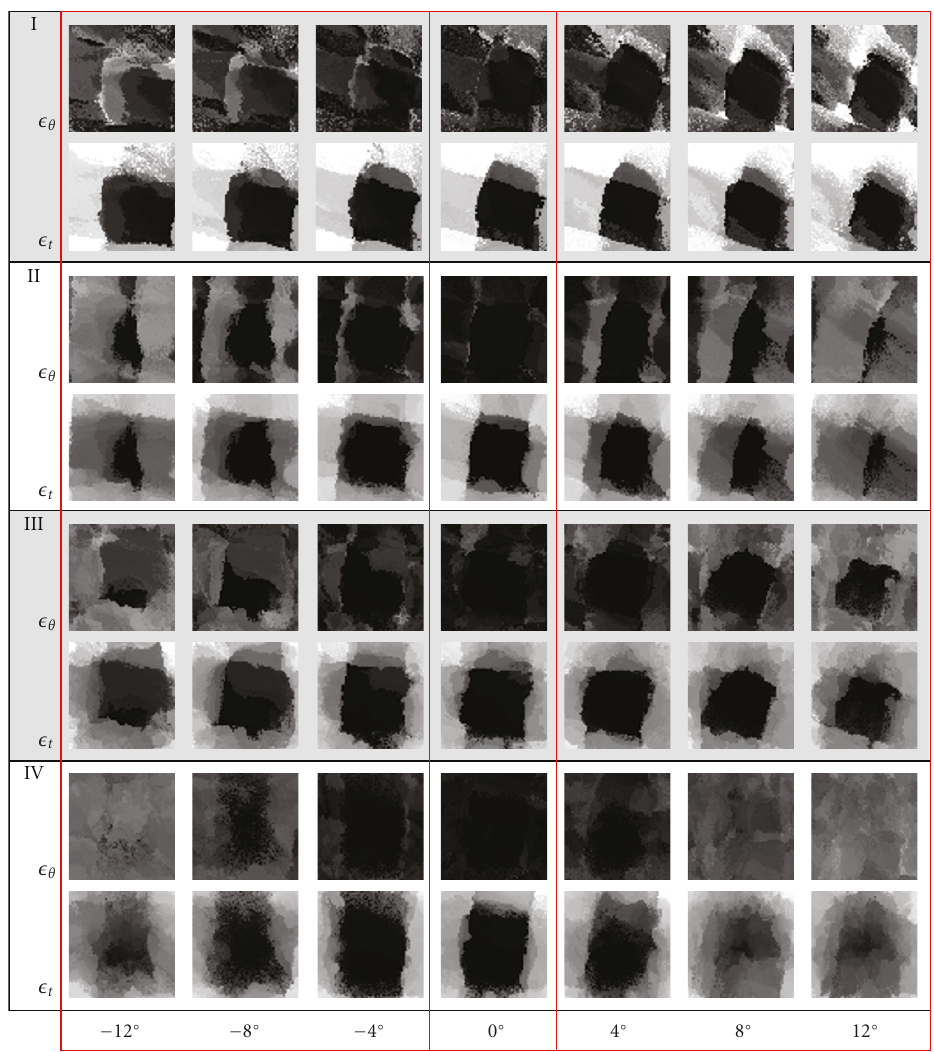
Figure 8: Results of local evaluation for the four landmarks. For each landmark (I–IV) the error images (cid:2) θ and (cid:2) t are shown for di ff erent rotation. All images of the same error type are scaled in the same way. Darker means less